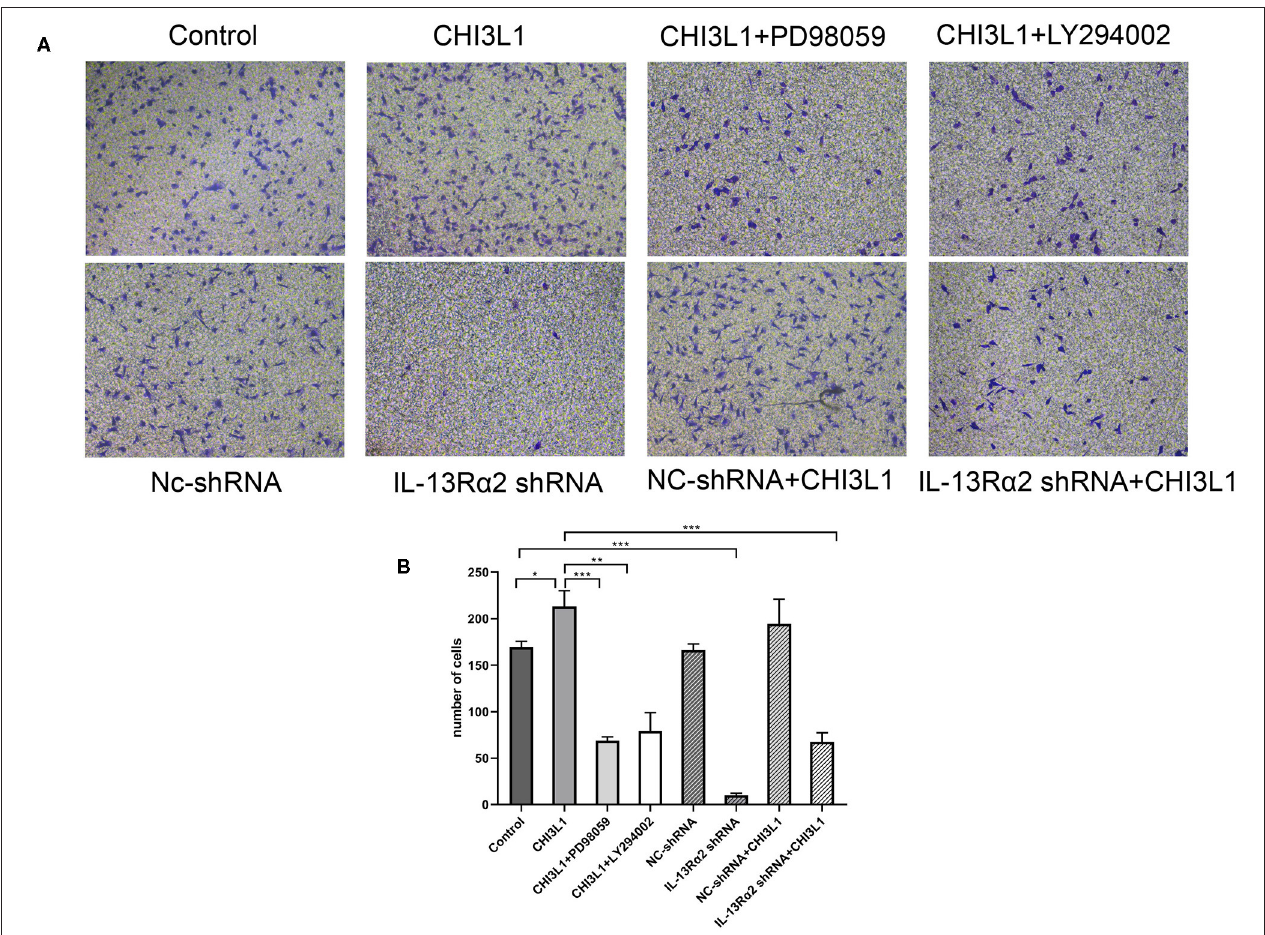
FIGURE 4 | The migration of HUVECs was measured via transwell assay (magnification 200 × ). The effects of CHI3L1 on HUVECs migration were tested in the presence or absence of IL-13R α 2 shRNA, MEK (PD98059) inhibitor, and PI3K (LY294002) inhibitor (A) . The number of migration cells was calculated (B) . Data were presented as mean ± SD ( n = 3 per group). * p < 0.05, ** p < 0.01, and *** p <